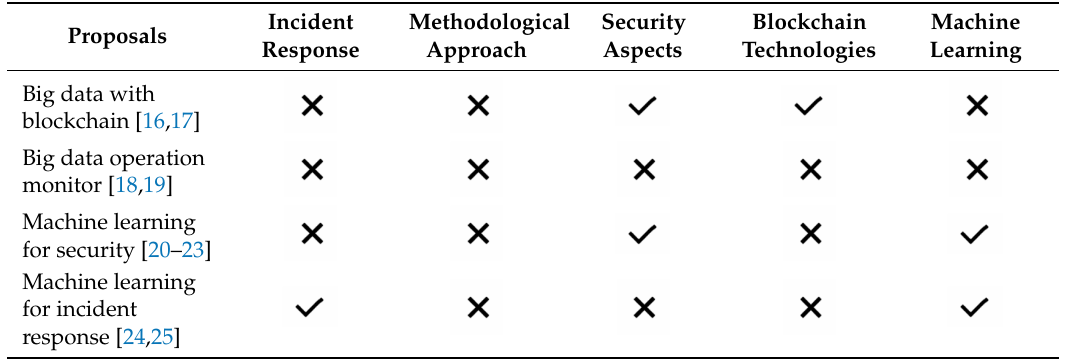
Table 1. Comparison of the related